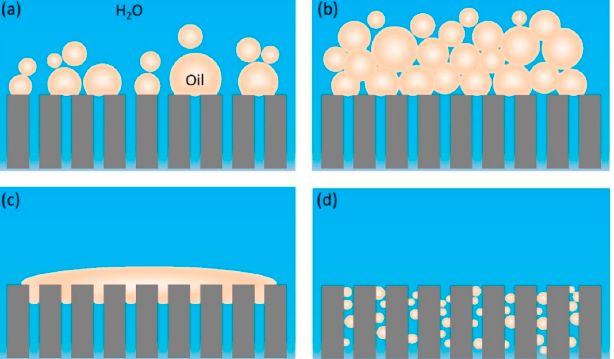
Figure 10. Various oil fouling models in oily wastewater filtration. ( a ) Oil droplets are partially blocking the membrane pores. ( b ) Cake layer formation on the membrane. ( c ) Continuous oil film formation on the membrane. ( d ) Oil droplets within the membrane pores. Reprinted with permission from ref. [203]. Copyright 2020 Elsevier Ltd.